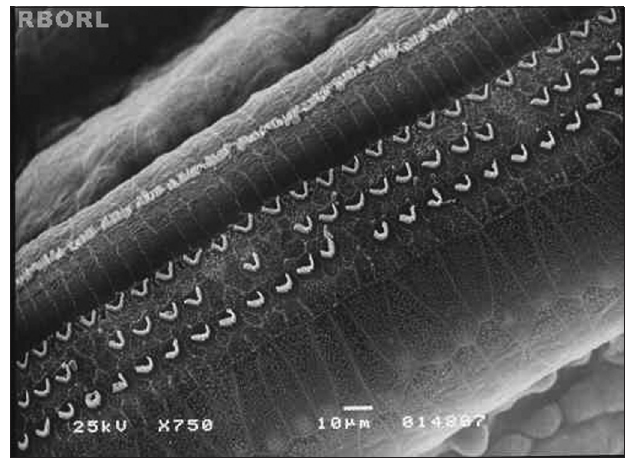
Figura 2. Fotomicrografia de órgão de Corti normal encontrado em cobaia do grupo 2, exibindo espira E2. Observe ausência de CCE em F2 e F3. CCI: células ciliadas internas; CCE: células ciliadas externas; F1: espira 1; F2: espira 2; F3: espira 3. Ampliação 750x.